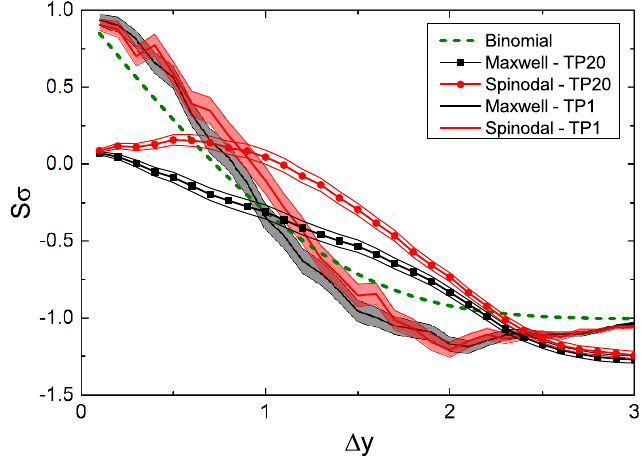
Figure 11 . The normalized skewness of the net baryon number as function of the rapidity window size around mid-rapidity. Di(cid:11)erent scenarios are shown: the results for TP=1 and TP=20 with spinodal and Maxwell EoS, as well as a binomial baseline.